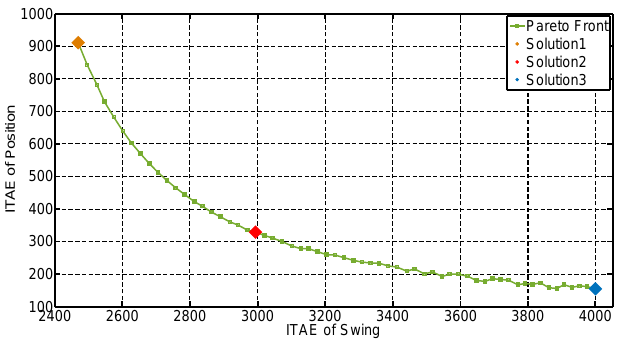
Figure 5. Pareto optimal front.